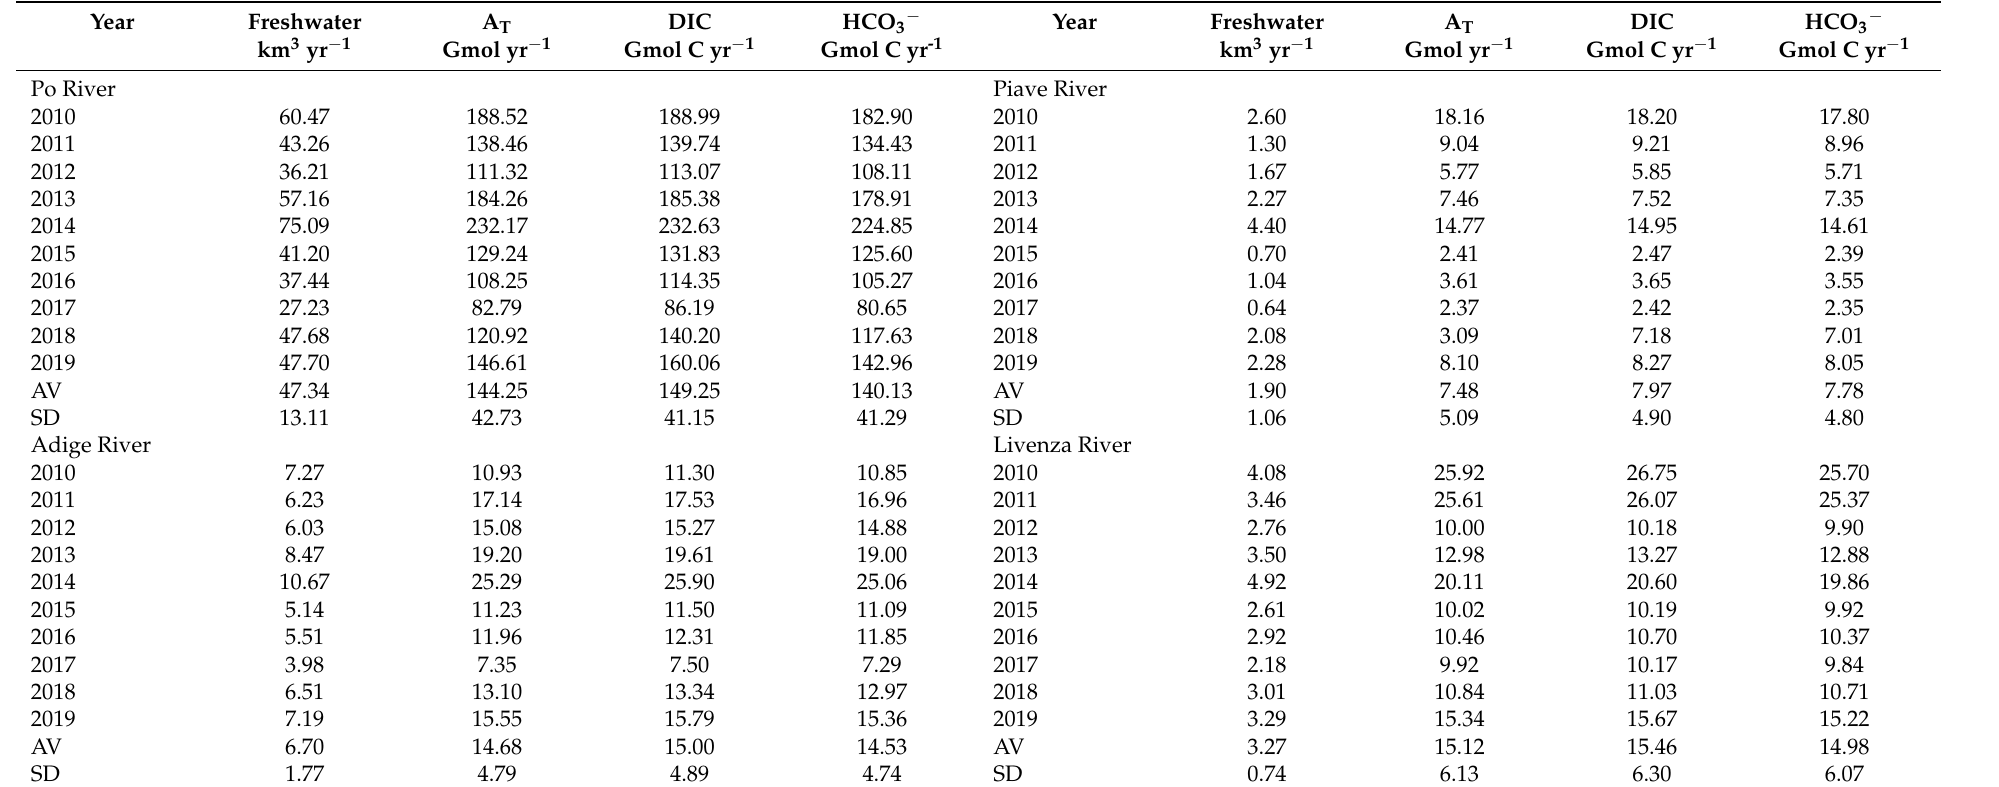
Table A2. Annual discharges of freshwater, total alkalinity (A T ), dissolved inorganic carbon (DIC) and bicarbonates (HCO 3 − ) by the northern Adriatic rivers. Averages (AV) and standard deviations (SD) are